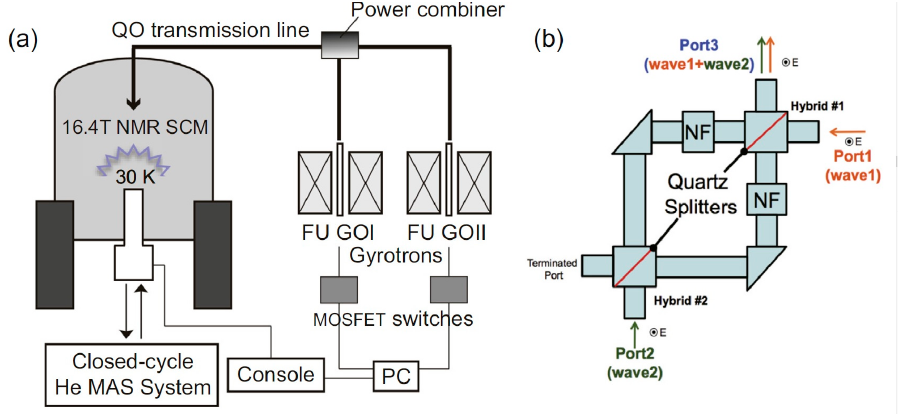
Figure 4. ( a ) Diagram of 460 GHz-700 MHz DNP-NMR spectrometer with two gyrotrons. Two sub-millimeter waves (SMMWs) can be independently delivered to a DNP MAS NMR probe. MAS is performed with a closed-loop helium circulation system. ( b ) A diagram for the custom-designed beam combiner for SMMWs, based on the corrugated waveguide sections, a set of 3 dB-hybrids, and tunable Notch filters. Reprinted with permission of Elsevier from Ref. [62].